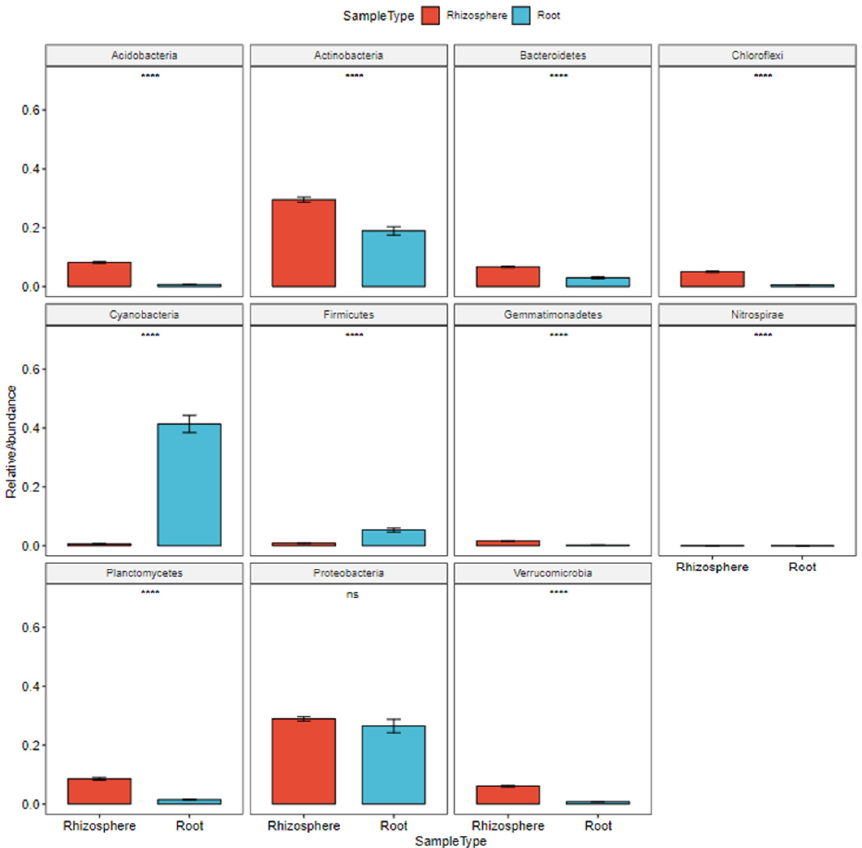
Figure 3. Relative abundances of genera (Acidobacteria, Actinobacteria, Bacteroidetes, Chloroflexi, Cyanobacteria, Firmicutes, Gemmatmonadetes, Nitrospirae, Planctomycetes, Proteobacteria, and Verrucomicrobia). Ten were significantly different between root and rhizosphere samples. Stand ‐ ard errors are represented in the figure by the error bars attached to each column (ns, not signifi ‐ cant; ‘‘*’’, p < 0.05; ‘‘**’’, p < 0.01; ‘‘***’’, p < 0.001; ‘‘****’’, p < 0.0001).